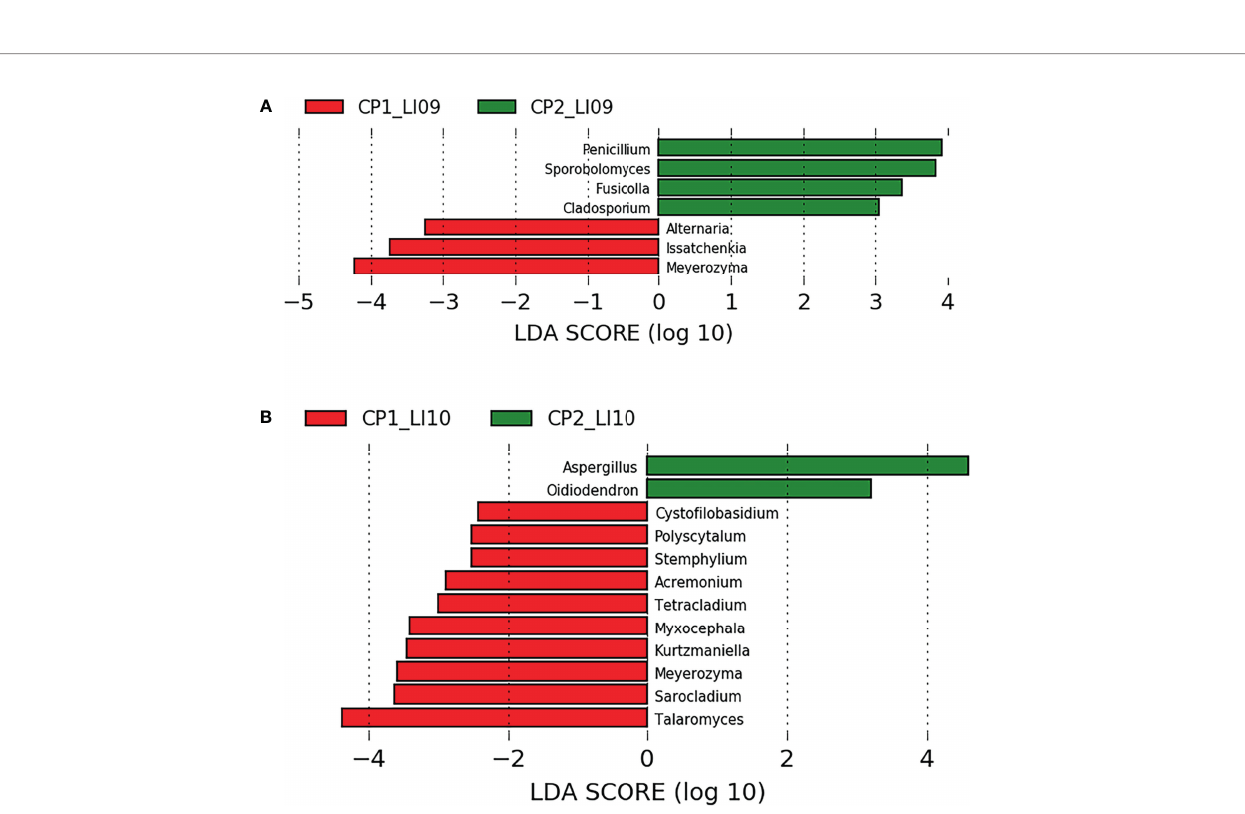
FIGURE 8 | LEfSe analysis determined the fungi associated with (A) LI09 cohorts with different cytokine pro fi les (i.e., CP1_LI09 and CP2_LI09 cohorts) and (B) LI10 cohorts with different cytokine pro fi les (i.e., CP1_LI10 and CP2_LI10